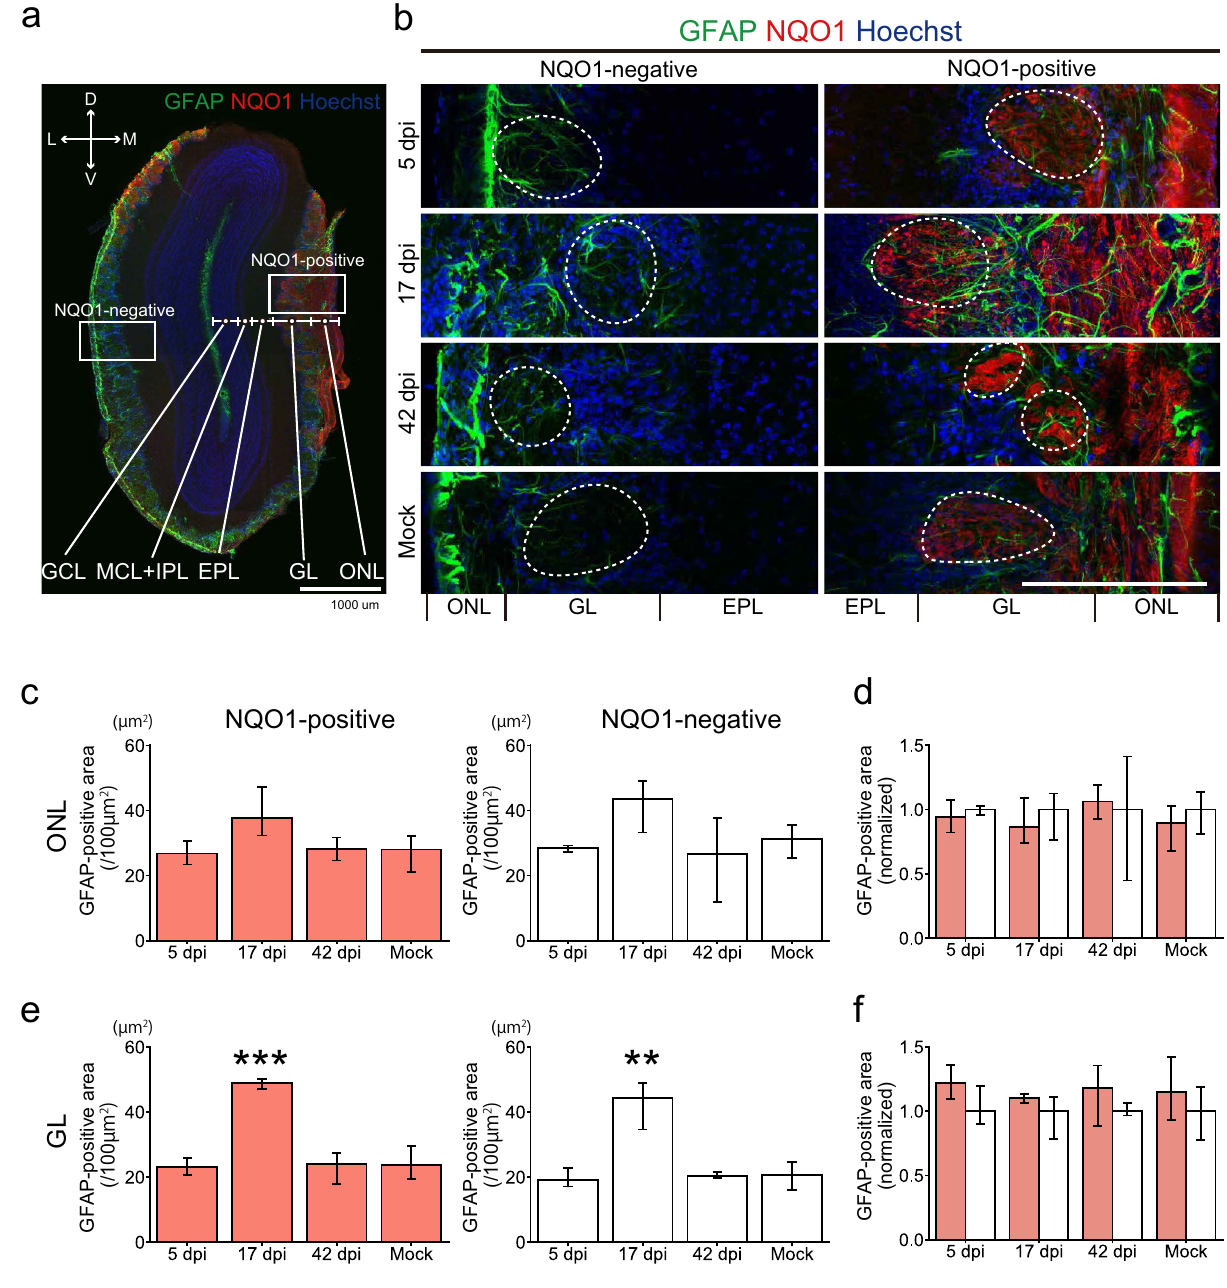
Figure 7. GFAP-positive cells in the OB. (a) Representative coronal section of the OB stained with glial fibrillary acidic protein (GFAP), NQO1, and Hoechst. Scale bar, 1 mm. (b) Representative images of the olfactory nerve layer (ONL), glomerular layer (GL), and external plexiform layer (EPL) stained with GFAP, NQO1, and DAPI. White dashed circles indicate glomeruli. Scale bar, 200 μm. (c,e) Areas of GFAP-positive cells in the ONL and GL (n = 3, one-way ANOVA followed by Dunnett’s post hoc test. **p < 0.01, ***p < 0.001). ( d,f ) Comparison of the normalized values of the density of GFAP-positive cells between NQO1-positive and NQO1- negative regions in the ONL and GL (n = 3, Welch’s